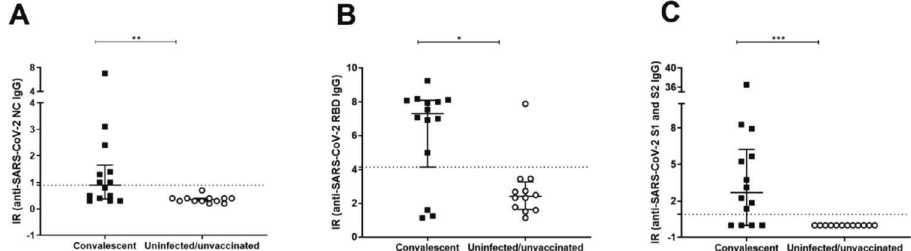
Figure 4 - Detection of anti-SARS-CoV-2 specific IgG. Serum samples obtained from COVID-19 convalescent individuals (n=14) and uninfected/unvaccinated donors (n=12) were analyzed to determine the IgG antibody reactivity index (RI) to nucleocapsid (NC) (A), the receptor-binding domain (RBD) (B), and spike (S1 and S2) (C). Scatterplots show lines at the median with interquartile ranges. Dotted lines represent the sample classification cut-off for each test. T-tests and nonparametric Mann-Whitney tests were used to compare the studied groups (* p o 0.05; ** p o 0.005; *** p o